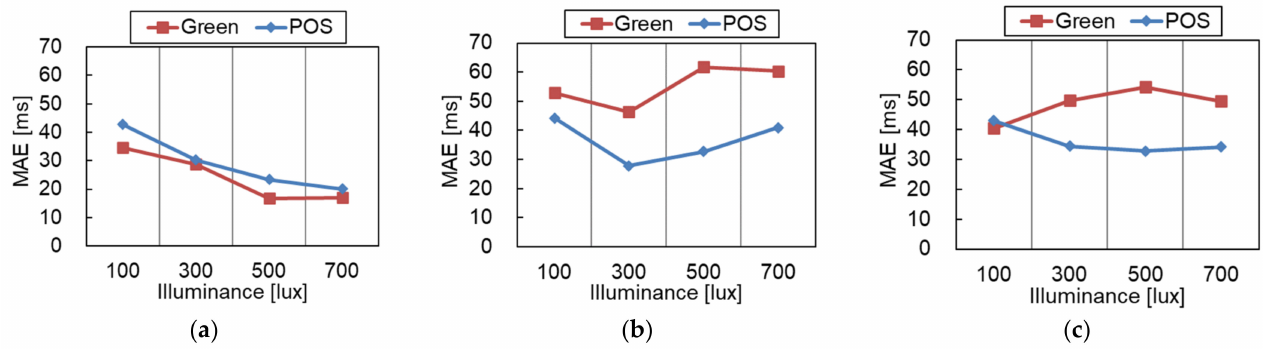
Figure 4. Mean absolute error (MAE) of RRI under different illuminance directions: ( a ) FR (Front), ( b ) TO (Top), and ( c ) FR-TO (Front and